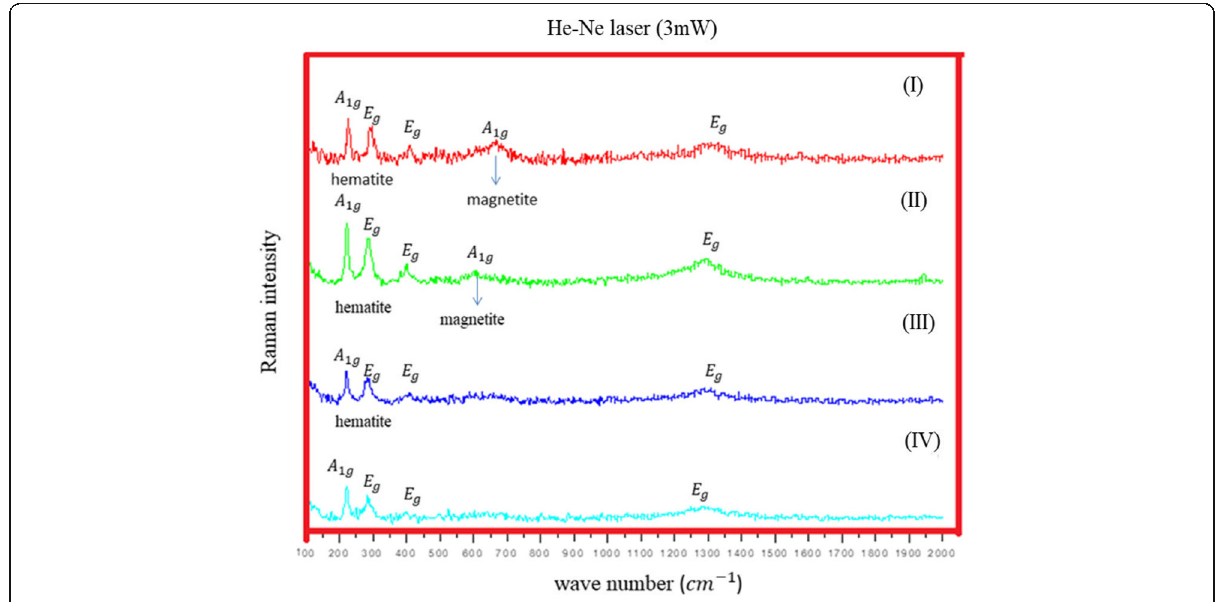
Fig. 8 Raman Spectra of Fe NCs-0 (I), Fe NCs-2 (II), Fe NCs-4 (III), Fe NCs-6 (IV) at 3 mW laser power with He-Ne